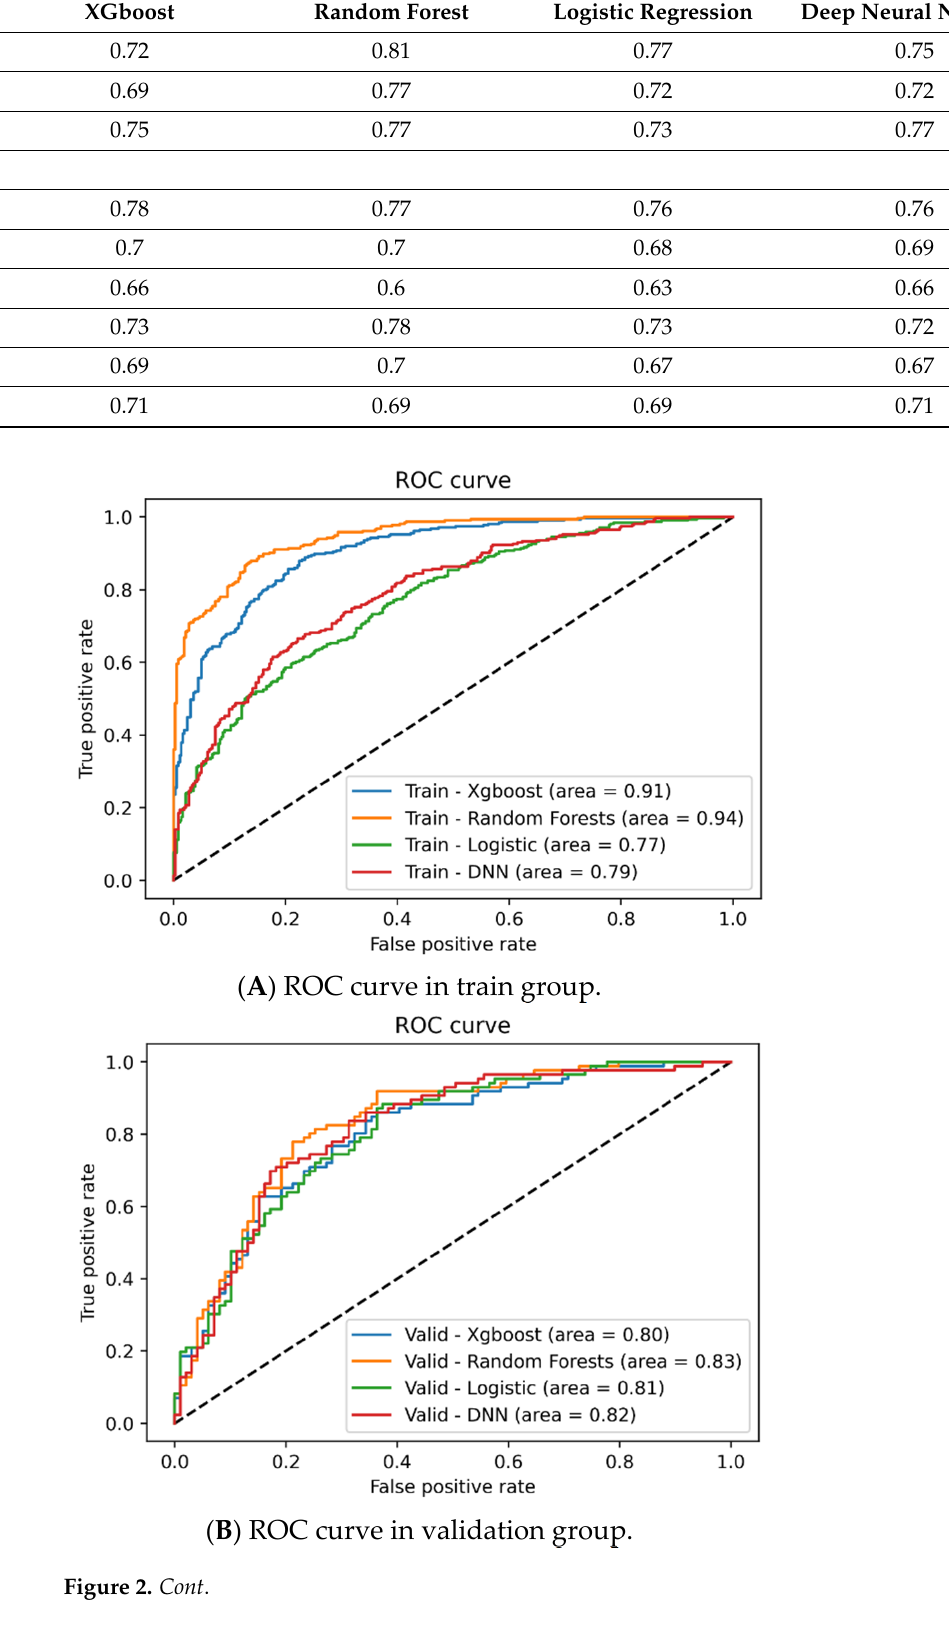
( C ) ROC curve in test group. Figure 2. Prediction of insulin resistance in patients with CKD using XGboost, random forest, lo- gistic regression, and DNN in train ( A ), validation ( B ), and test group ( C ). In the train group ( A ), RF had the highest AUC (0.94), followed by XGboost (0.91). In the validation group ( B ), AUCs of ROC